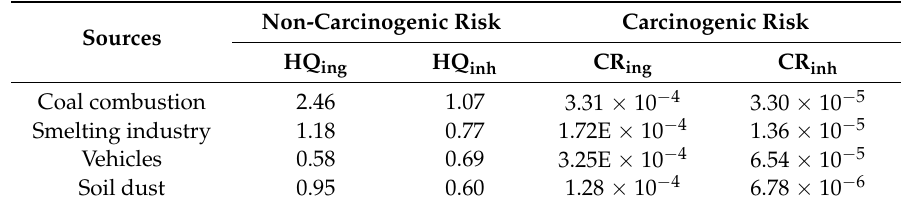
Table 3. The hazard quotient (HQ) and carcinogenic risks (CR) via ingestion and inhalation for Cr, Mn, Co, Ni, Cu, Zn, As, Cd, and Pb in PM 2.5 associated with